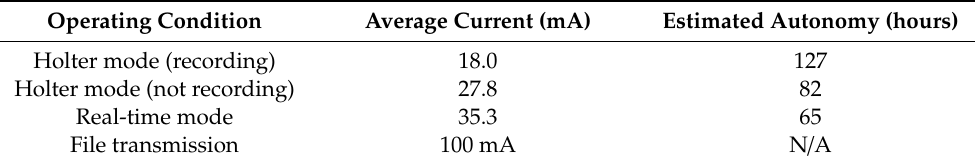
Table 6. Measurement of current drawn by the arm-ECG sensor system (WAMECG1).